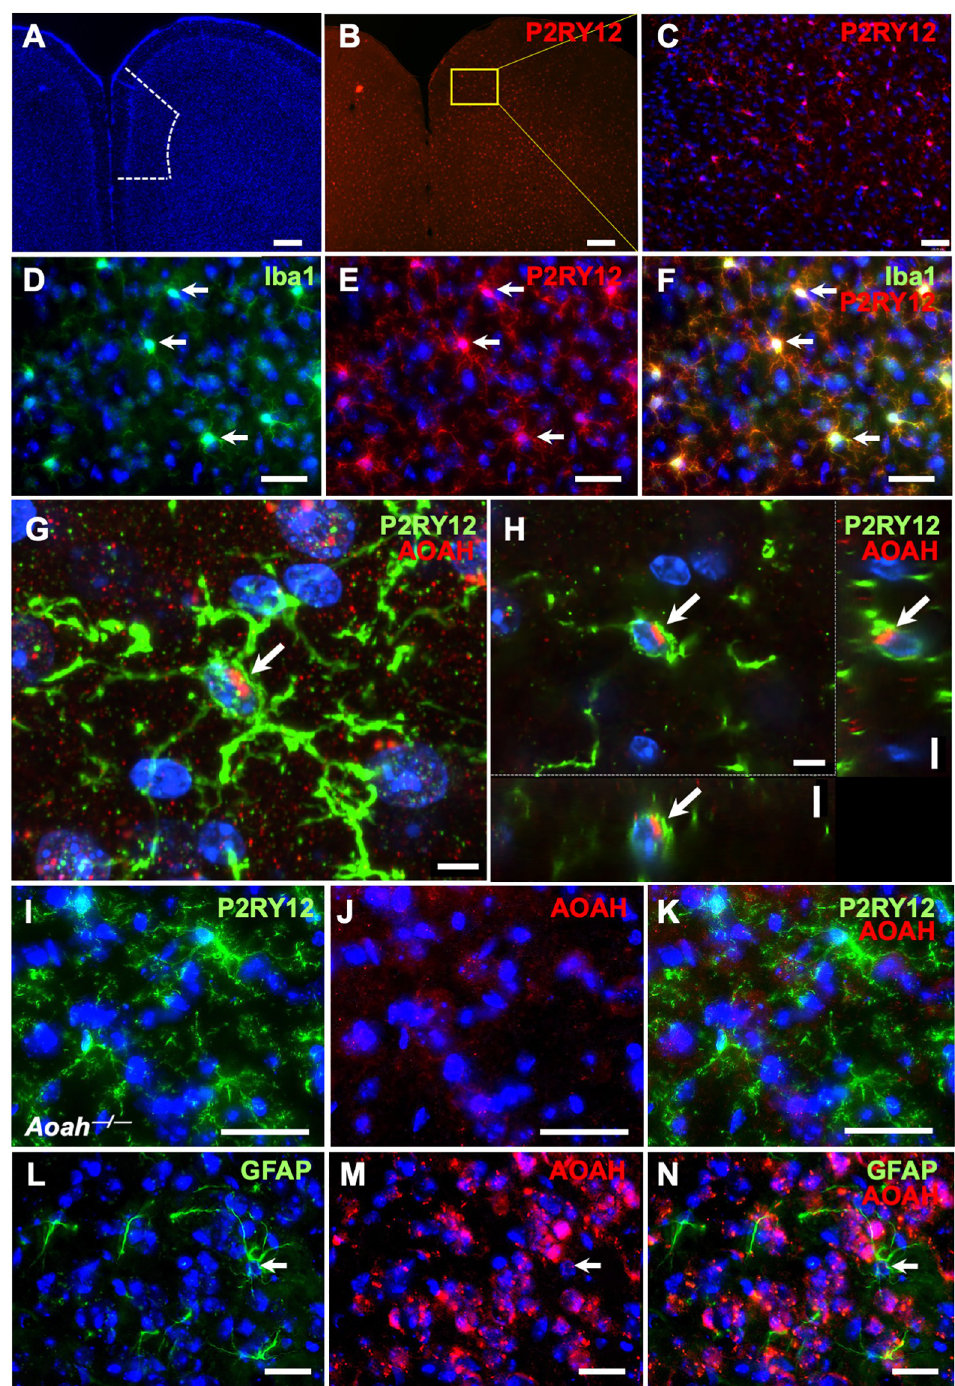
Fig 2. Immunostaining of AOAH in glial cells. A-C : P2RY12 staining labels microglia in murine P2RY12+ cells (red) in and beyond the prefrontal cortex (A, prefrontal cortex outlined in a single hemisphere by dotted line). A and B captured with 2.5X objective (scale bar: 120 μ m). C captured with a 20X objective (scale bar: 15 μ m). D-F : Combined z- stack of WT mouse prefrontal cortex stained for the microglial proteins Iba1 (green) and P2RY12 (red). DAPI staining nuclei shown in blue (n = 3 mice, scale bar: 30 μ m). Images were captured with a 40X objective. G and H : Confocal microscopy showing combined z-stack (G) and individual planes (H) obtained from WT mouse prefrontal cortex stained for microglial protein P2RY12 (green) and AOAH (red). DAPI staining nuclei shown in blue (n = 3 mice, scale bar: 5 μ m). Images were captured with a 60X objective. I-K : Staining of AOAH-deficient prefrontal cortex with